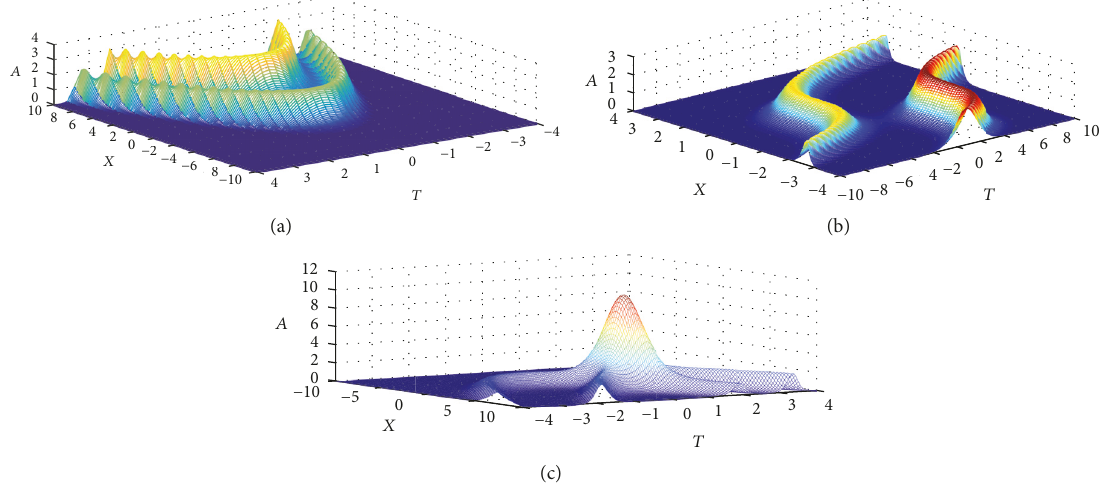
Figure 2: Interaction of the two solitons of ion-acoustic solitary waves with (a): 𝑎 1 = 1 , 𝑎 2 = 0.1 , 𝑎 3 = 1 , 𝑎 4 = 1 , 𝑘 1 = 1.6 , 𝑟 1 = 1 , 𝑞 1 = 1 , 𝑘 = −1.9 , 𝑟 2 𝑞 = 1 , 𝛼 = 0.7 , 𝛽 = 1 , 𝛾 = 1 , 𝜔 = 2.8 ; (c): 𝑎 2 𝛾 = 1 , 𝜔 = 2.8